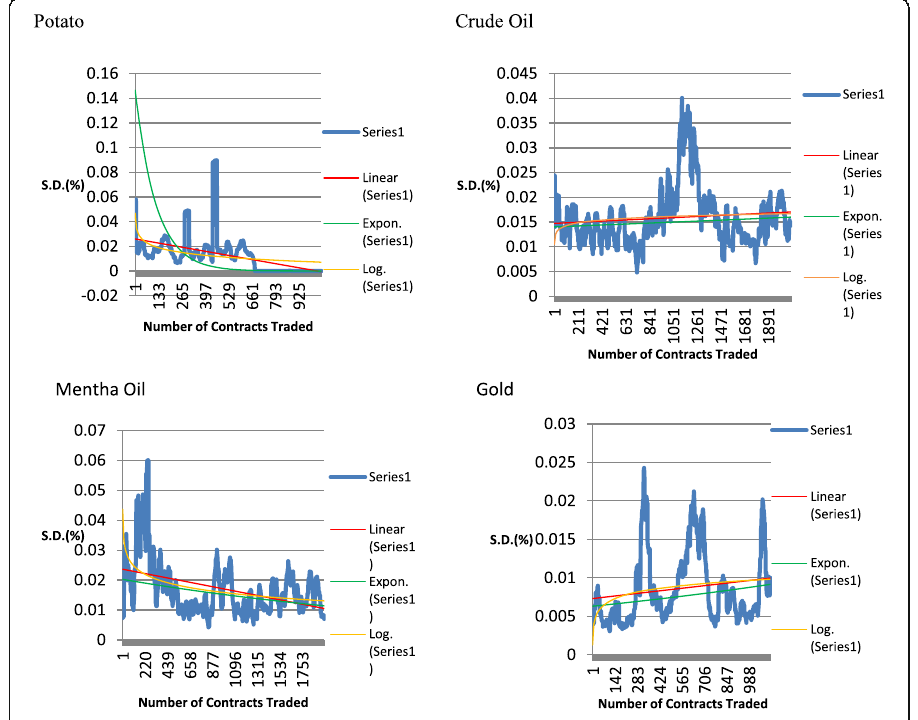
Fig. 2 Trends based on rolling standard deviation for 2 (next near) month contract